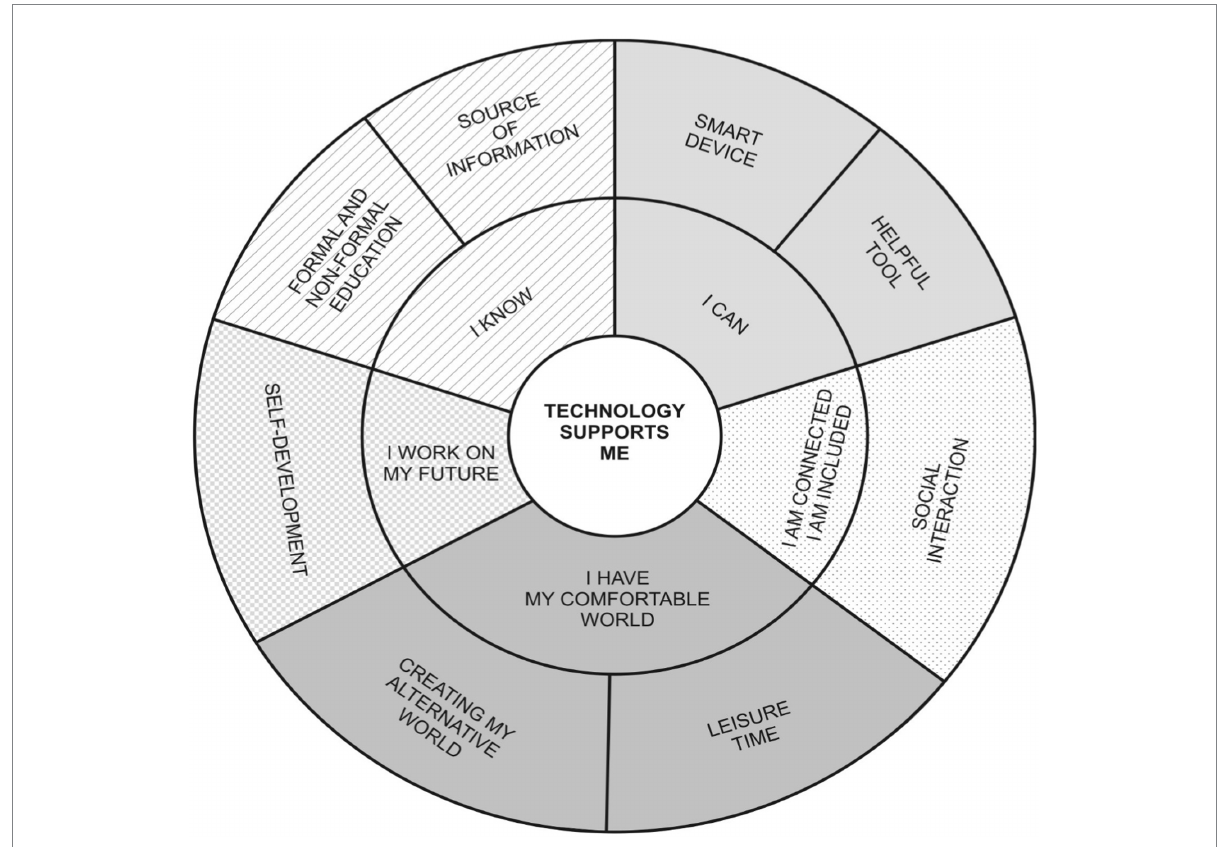
FIGURE 1 Model of themes and subthemes of perceived benefits of digital technology and Internet use by